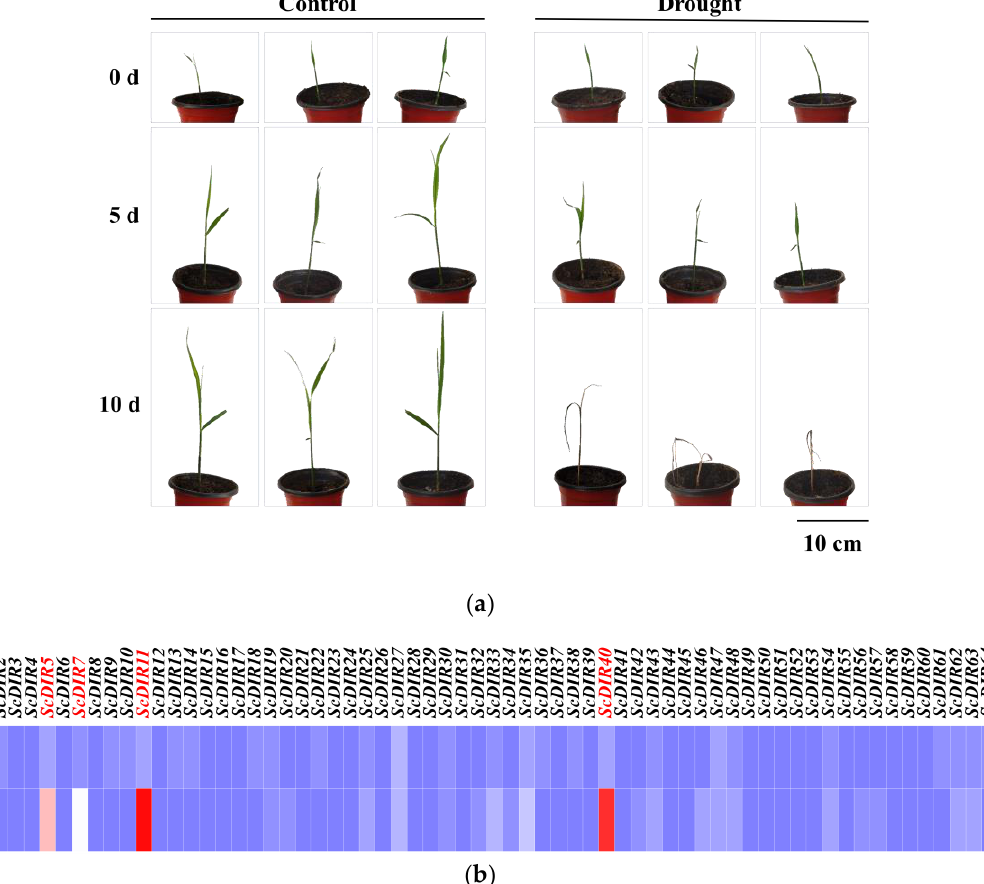
Figure 2. Relative expression pattern of sugarcane ScDIR genes under drought stress conditions. ( a ) Phenotypes of sugarcane seedlings at 0, 5, and 10 days of drought stress. ( b ) Relative expression of 64 ScDIR genes as measured by qRT−PCR. Analysis of expression differences in sugarcane seedlings after 0 and 5 days of drought stress compared with those in the absence of stress. Heatmap generation and hierarchical clustering were performed using the Heml 1.0.3.7 software package. The color scale below the heat map indicates expression values; blue indicates low transcript abundance while red indicates a high level of transcript abundance. GAPDH was used as an internal reference gene.